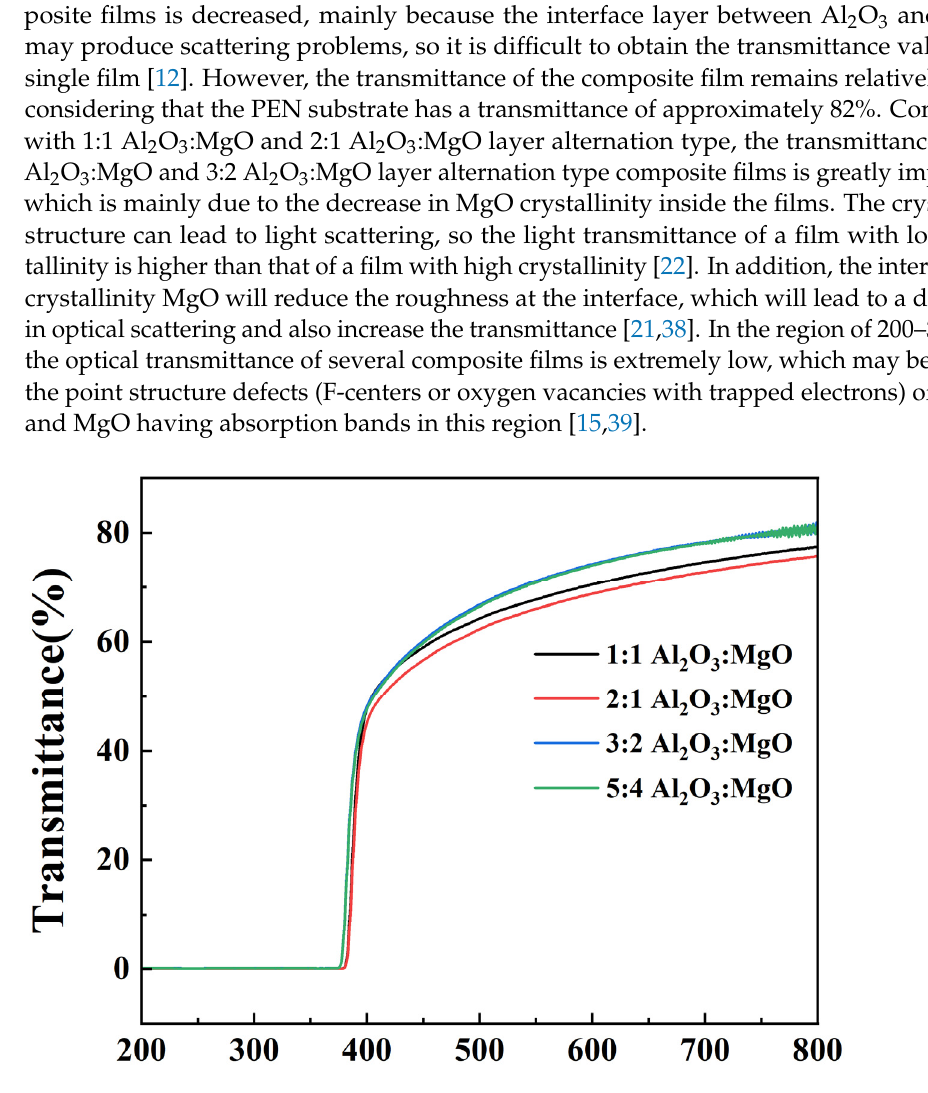
Figure 9. TEM high-resolution (HRTEM) images of different composite films: ( a ) 1:1 Al 2 O 3 :MgO layer alternation type, ( b ) 2:1 Al 2 O 3 :MgO layer alternation type, ( c ) 3:2 Al 2 O 3 :MgO layer alternation type, and ( d ) 5:4 Al 2 O 3 :MgO layer alternation type.